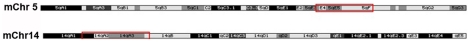
Chromosomal maps showing the identified QTL regions.A 20 cM region (red box) on the distal are of mCHr 5 and the proximal arm of mChr14 were identified by QTL analysis.